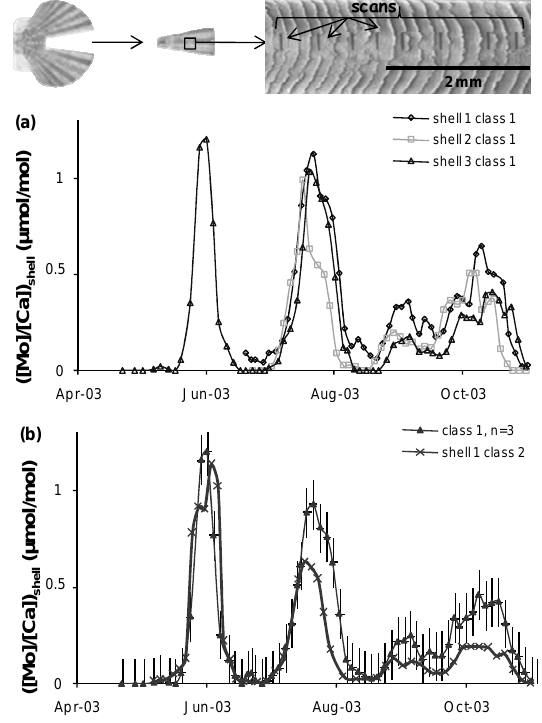
Fig. 1. Comparison of ([Mo]/[Ca]) shell concentration profiles along the shell section obtained for (a) three juvenile scallop shells (class 1); (b) the mean ([Mo]/[Ca]) shell concentrations of 3 juvenile shells with standard deviations as error bars and one 3-years old scallop shell (class 2), collected in the Bay of Brest (Roscanvel), in 2003, to evaluate the inter shell reproducibility of ([Mo]/[Ca]) shell variations.